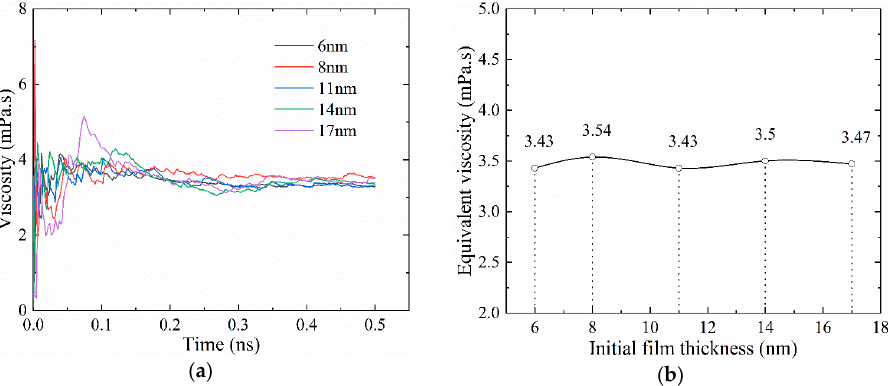
Figure 3. The lubrication film viscosity under the non-working state ( P = 0.1 MPa, T = 300 K): ( a ) evolution of viscosity; ( b ) time-average viscosity of different initial film thickness.